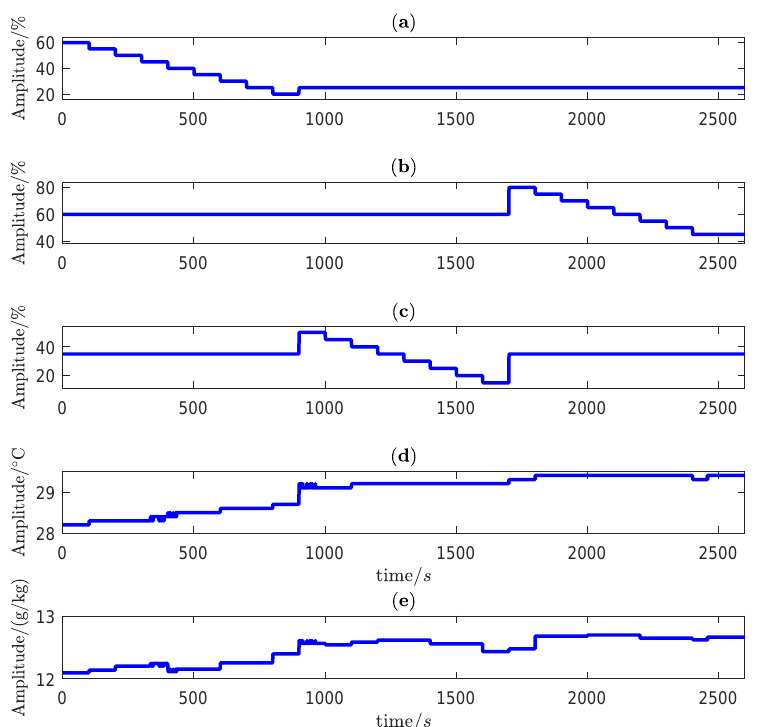
Figure 6. The measured input variables for estimating model coefficients: ( a ) R SA , ( b ) R CW , ( c ) R CHW , ( d ) T out and ( e ) D out